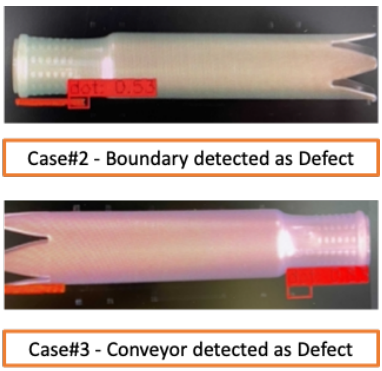
Figure 15. Error cases found in the trial